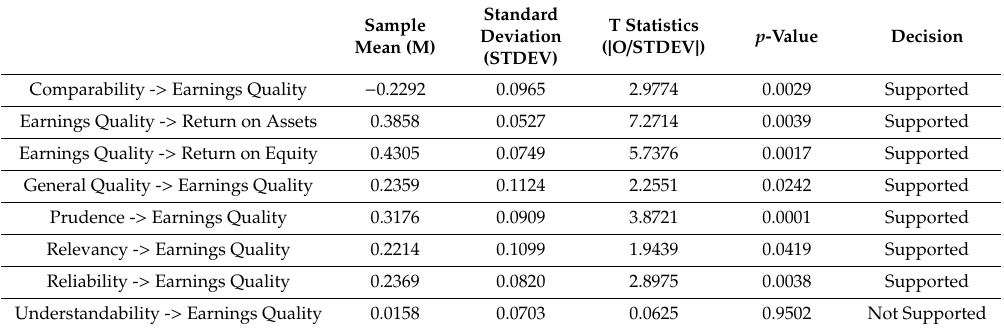
Table 7. Hypotheses Testing.